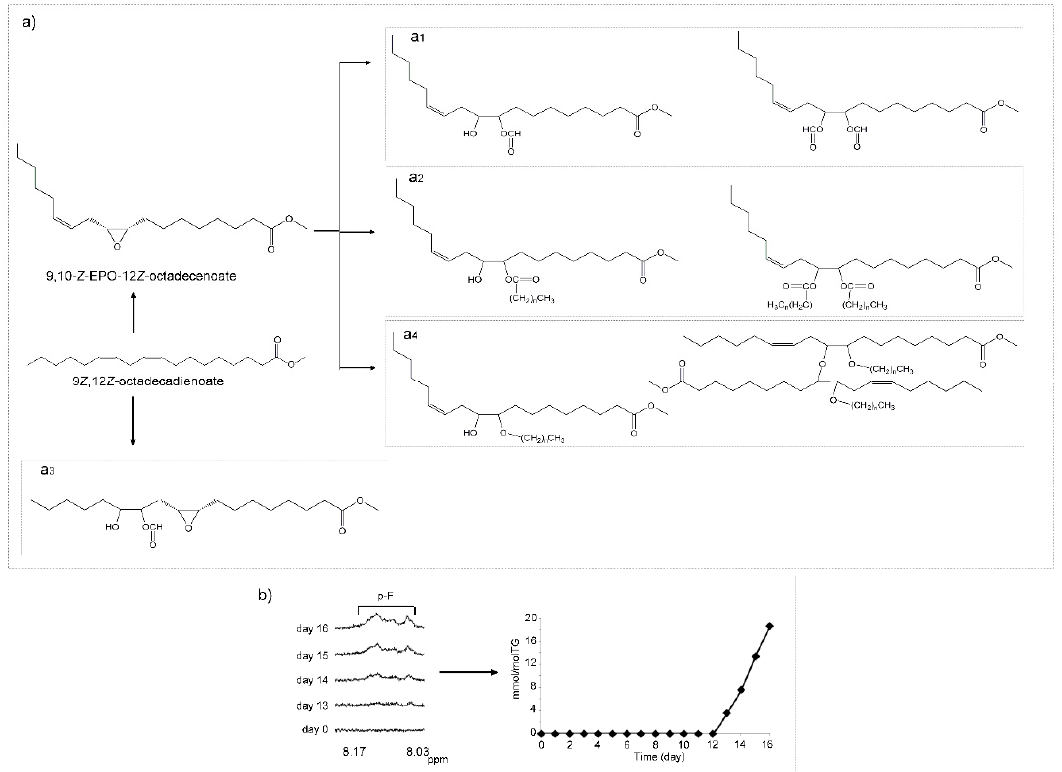
Figure 13. ( a ) Pathways of formation of poly-formates, poly-ester and poly-hydroxy structures ( a 1 , a 2 and a 3 ), and poly-ether and poly-hydroxy structures ( a 4 ), proposed by some authors [93,96,97]; ( b ) enlargement of region of the 1 H NMR spectra in which the signals of poly-formates appear together with evolution of their concentration, expressed as mmol/mol TG versus time given in days.